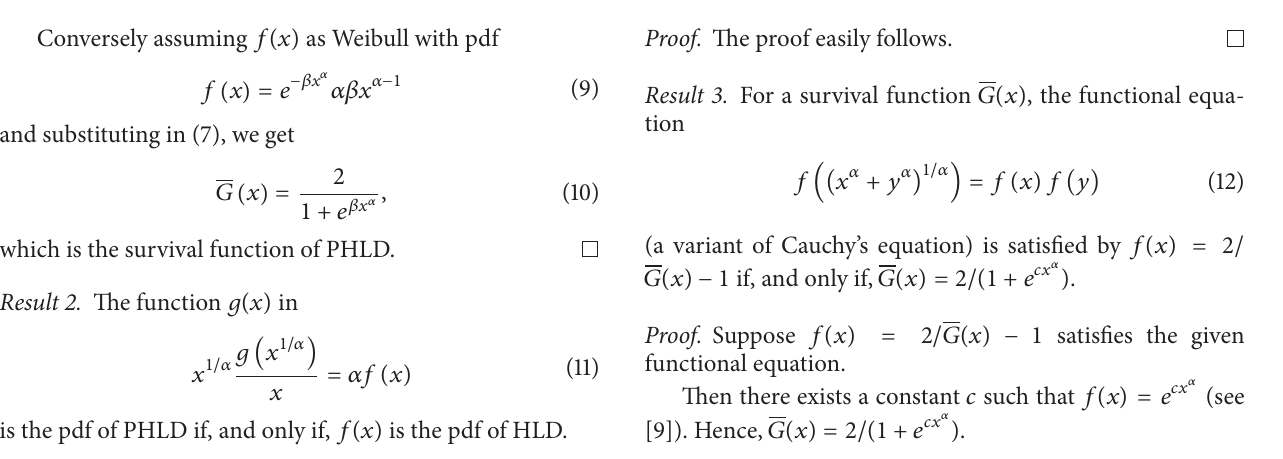
Figure 2: Comparison of PHLD, HLD, and Weibull